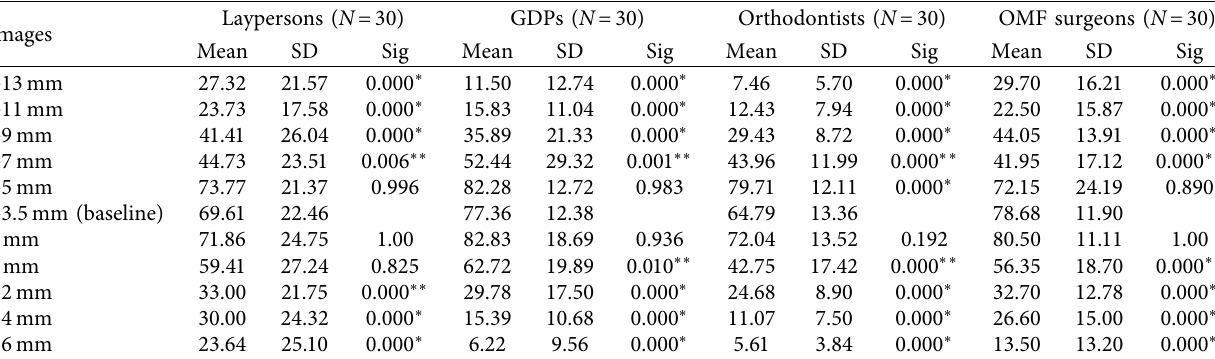
Table 2: Means and SDs of the esthetic values for the baseline profile image and the manipulated mandibular retrusion and protrusion images as perceived by the four raters’ groups.